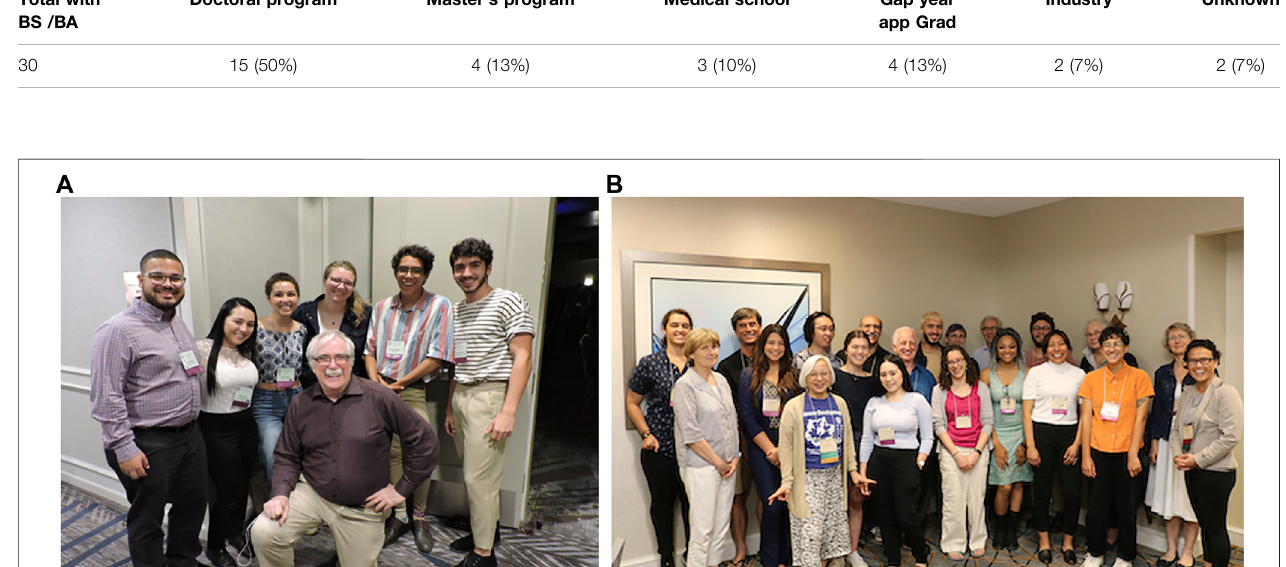
FIGURE 2 | (A) : Choose Development! Fellows at the 2018 SDB Annual Meeting meet Nobel Laureate Dr. Eric Wieschaus (center). Fellows from left to right: Evan Brooks,AlexisCamacho-Avila, Amber Rock,CarolinePritchard,ChristianWilsonandJoseanReyesRivera. (B) : ChooseDevelopment! Fellows atthe2019SDBAnnual Meetinglunchwithrenowneddevelopmentalbiologists.Fromlefttoright:LindseyHernandez(2018);RuthLehmann;RichardBehringer;AdrianaVélez(2018 – 2019);Ida Chow; QinanHu(Lab Mentor); TaliaHart(2015);Martin Chal fi e;Alexis Camacho-Avila (2017 – 2018); Mario Capecchi; JoseanReyesRivera(2016, 2018); Rebecca Green (Lab Mentor); Brigid Hogan; Doug Melton; Grace Jean (2018); Davys Lopez (2013); Diana Ramirez (2018 – 2019); Christiane Nuesslein- Volhard; Amanda Neves (2018); Lilianna Solnica-Krezel; Graciela Unguez. Martin Chal fi e, Mario Capecchi, and Christiane Nuesslein-Volhard are all Nobel Laureates; Ruth Lehmann, Brigid Hogan, Doug Melton and Lilianna Sonica-Krezel are all members of the National Academy of Science and SDB past presidents.